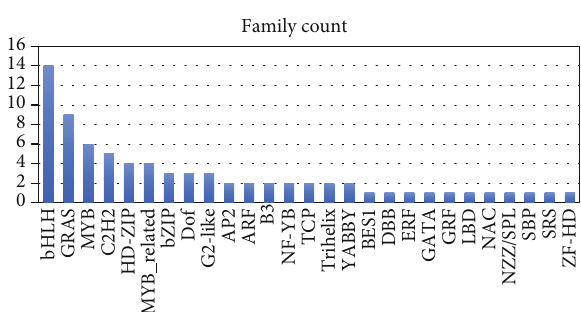
Figure 10: Distribution of downregulated transcription factors (TFs) under